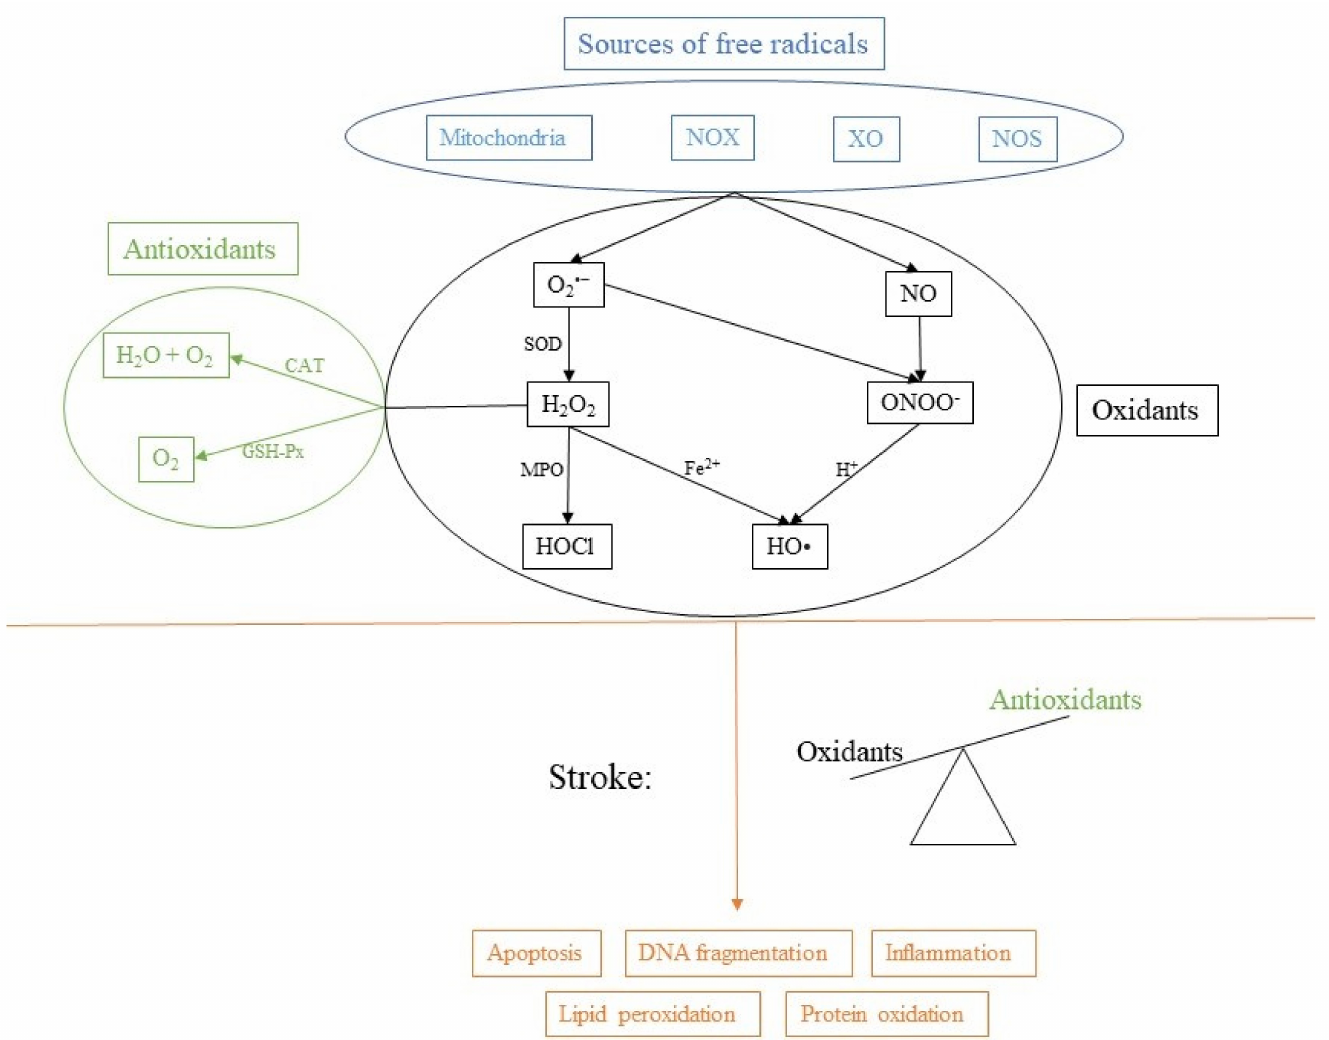
Figure 1. Sources of free radicals and consequences of imbalance. NADPH oxidase (NOX), xanthine oxidase (XO), nitric oxide synthase (NOS), superoxide dismutase (SOD), myeloperoxidase (MPO), catalase (CAT) and glutathione peroxidase